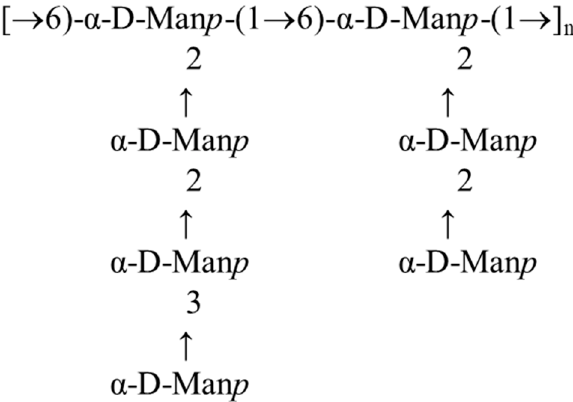
Figure 8. Structure of the highly branched α -D-mannan constituting the main component of the Le-P-Se and Le-P-0 fractions.